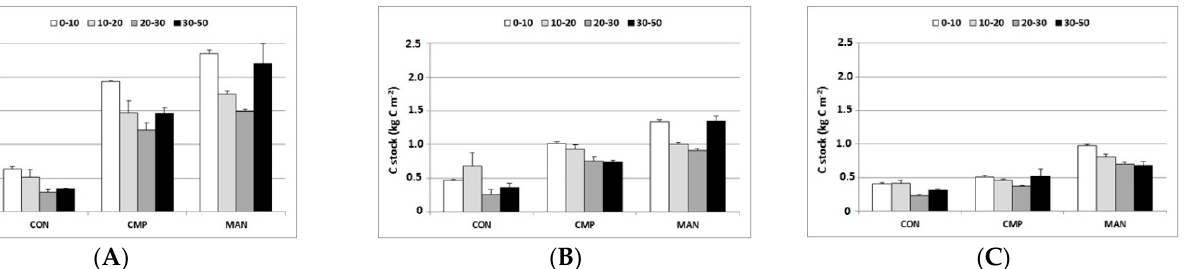
Figure 2. Change in soil OC stocks over 8 years under the different treatments for the four sampled profile depths. (( A – C ) are respectively soil OC stocks in 2013, 2016, and 2020). Table 4. Evolution of soil OC and N stocks between 2013 and 2016.